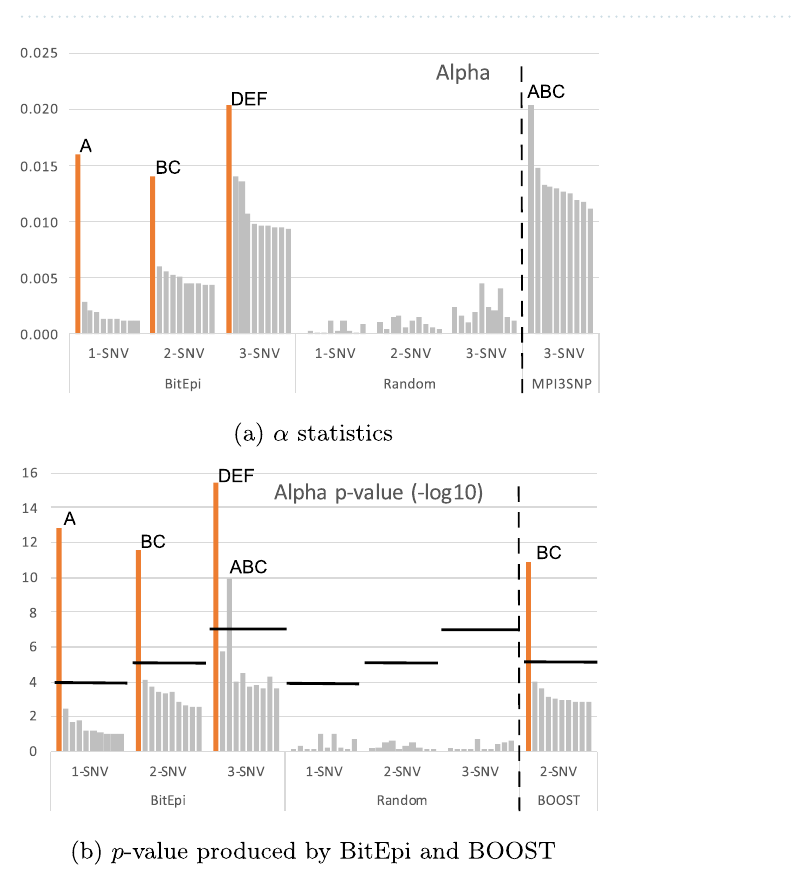
Figure 5. α and p -value for the top ten variables and ten randomly selected variables of E123